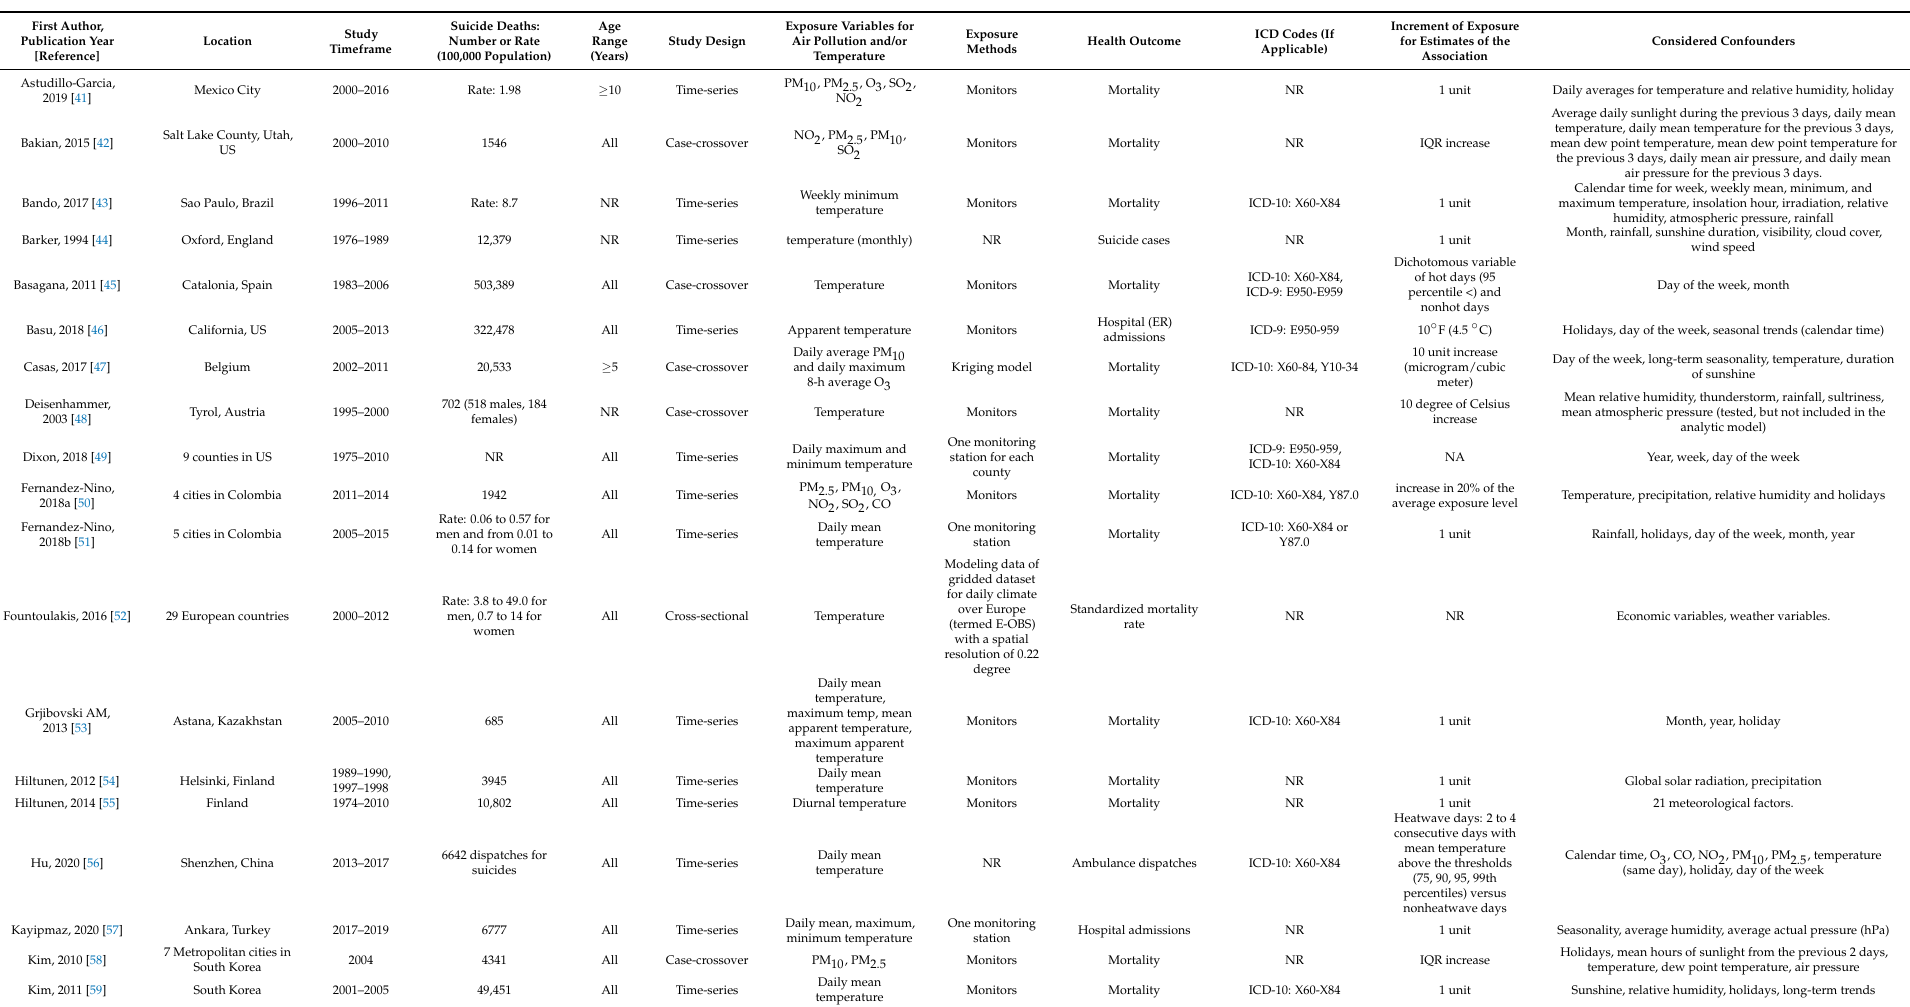
Table 2. Characteristics of the included